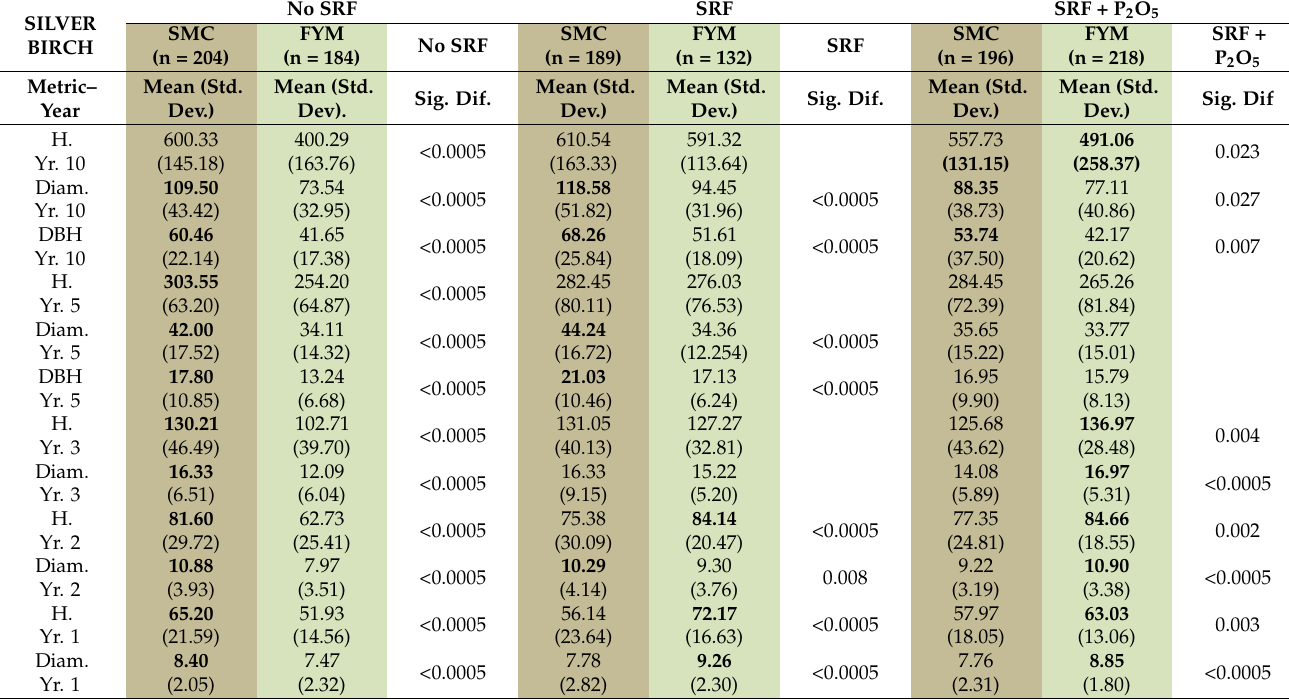
Table 13. Comparison of Silver Birch with SMC- or FYM-planting compost and fertilizer. (Nb: height (H) cm; DBH: mm, Diam. (diameter above root collar): mm; ratio FYM/SMC; ns: differences not significant).